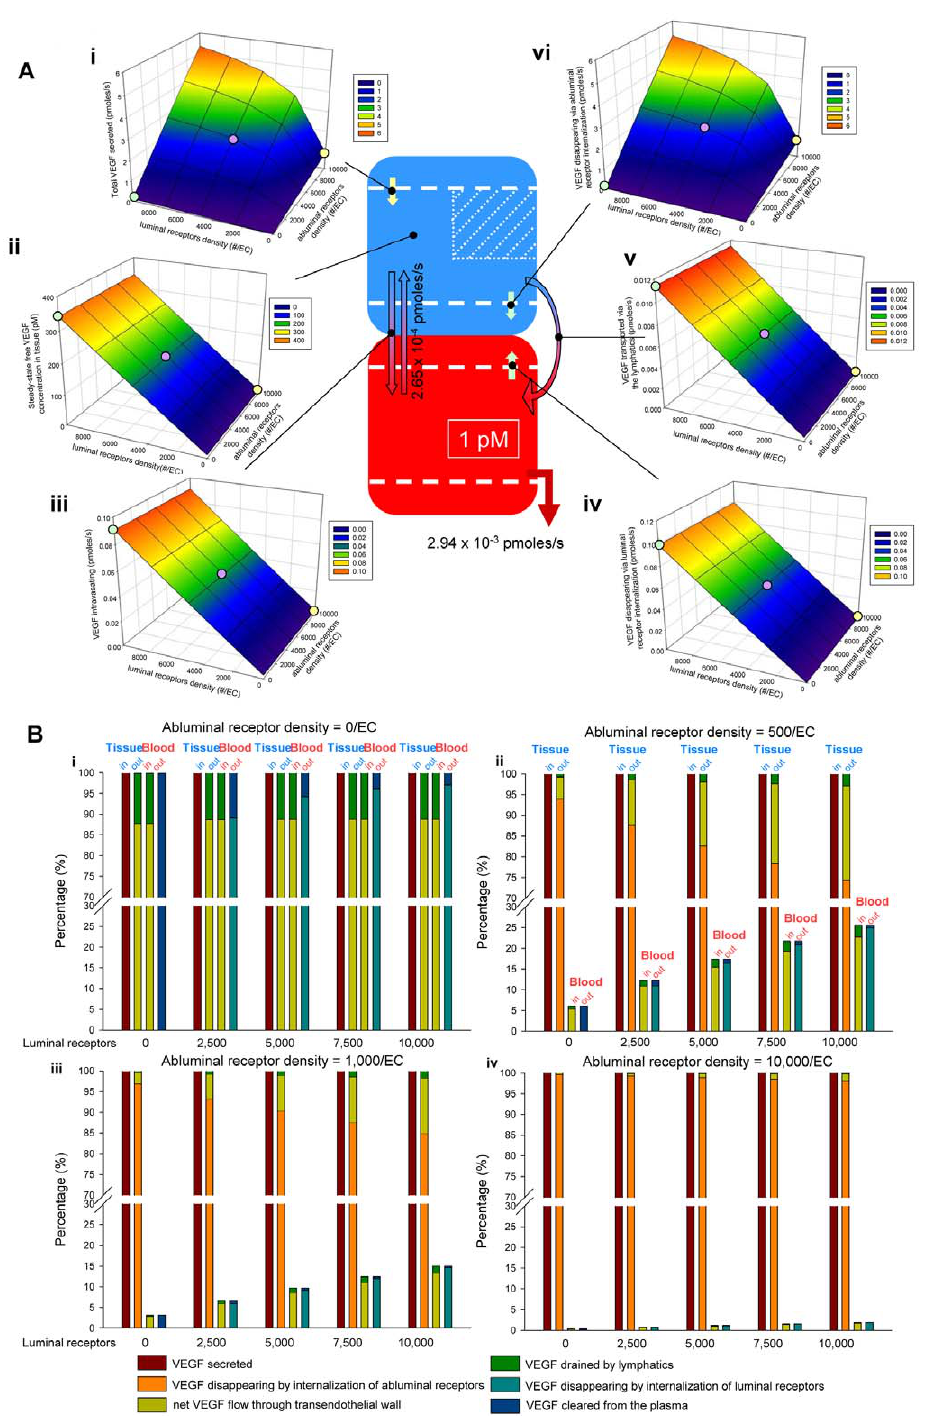
Figure 4. Flow diagrams for a fixed concentration of free VEGF in the plasma. A. The inflows and outflows are expressed in pmoles/s. The density of luminal and abluminal receptors was varied from 0 to 10,000 per endothelial cell. Free VEGF concentration in the plasma was fixed at 1 pM for a vascular permeability of 4 6 10 2 8 cm/s. From top left, counter-clockwise: i. VEGF secreted per parenchymal cell; ii. free VEGF concentration in the tissue (in pM); iii. VEGF intravasating; iv. VEGF disappearing through internalization of the luminal receptors to which it binds; v. VEGF drained through the lymphatics; vi. VEGF disappearing through internalization of abluminal receptors to which it binds. VEGF extravasating and VEGF cleared from the plasma are constant over the course of the simulations due to the fixed free VEGF concentration in the plasma and equal to 2.65 6 10 2 4 and 2.94 6 10 2 3 pmoles/s respectively. The yellow dot corresponds to the configuration of 10,000 abluminal receptors and no luminal receptors. The purple dot identifies an equal density of receptors on luminal and abluminal surfaces of the endothelial cells (5,000 receptors on each side per endothelial cell). The green dot corresponds to the case of 10,000 luminal receptors and no abluminal receptors. B. Flows normalized to VEGF secretion for different luminal receptor densities: i. no abluminal receptors; ii. 500 abluminal receptors per EC; iii. 1,000 abluminal receptors per EC; iv. 10,000 abluminal receptors per EC. EC=endothelial cell.